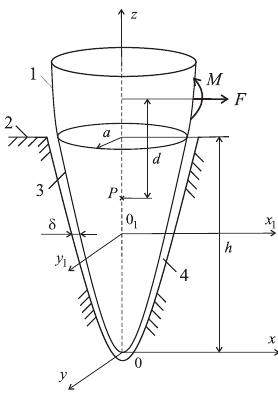
Figure 1. Model of initial translational motion of tooth root in PDL: 1 – tooth crown; 2 – dental alveolus; 3 – tooth root; 4 – periodontal slit of constant thickness normal to root surface; F – concentrated force acting on the tooth crown; M = Fd – couple (couple is orthogonal to the xy -plane); d – distance between application point of force and centre of rotation P ; a – radius of tooth root cross-section at level of alveolar crest; h – height of tooth root; δ – width of PDL in horizontal plane x 1 0 1 y 1 .